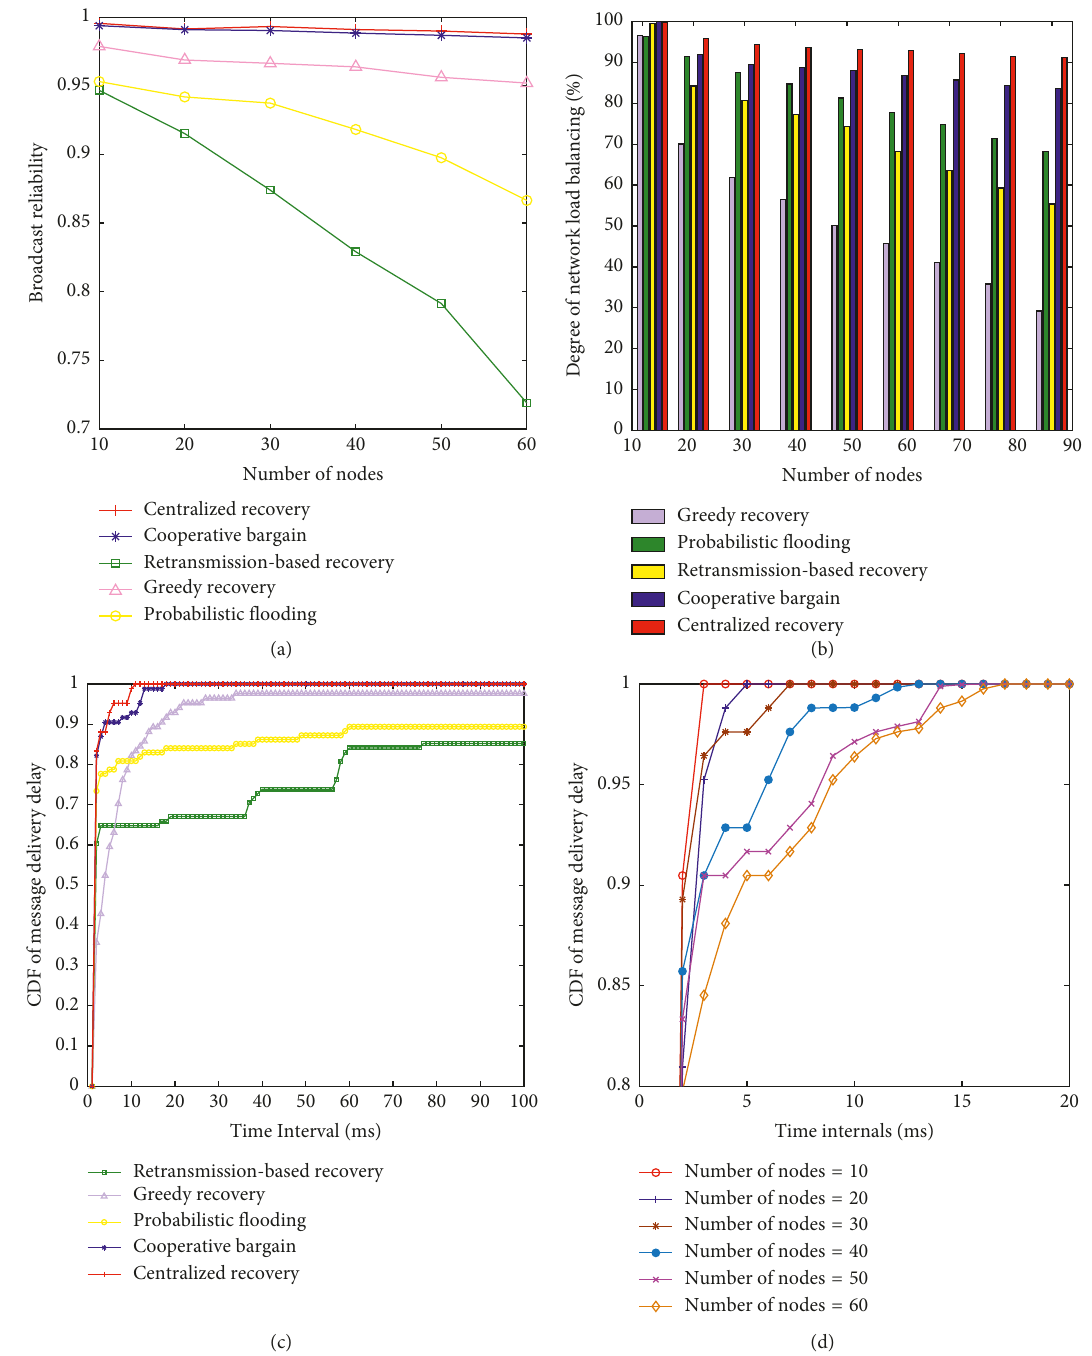
Figure 3: The performance evaluations on cooperative bargain. (a) Broadcast reliability. (b) Network load balancing. (c) Message delivery delay. (d) Recovery